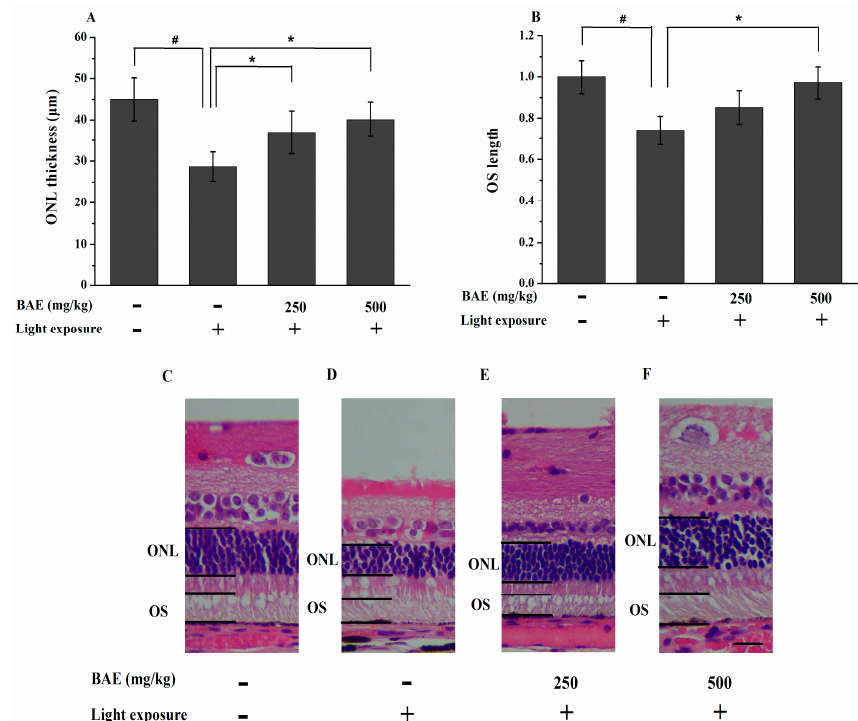
Figure 3. Effect of bilberry anthocyanin extract on the thickness of the outer nuclear layer ( A ) and the outer segment length ( B ) for the rabbit retina at 7 days after light exposure (18,000 lx) were examined by histological analysis. Thickness of the ONL were measured within 250–2750 μ m (counted at every other 500 μ m interval) of the superior and inferior edges to the optic nerve head (ONH) based on photographs of HE-stained sections. The OS length was measured 1 mm from the ONH in the superior and inferior retina. Data are expressed as the mean ± standard deviation ( n = 8). #, * p < 0.05 ( t -test); ( C – F ) Representative images of the HE-stained sections of retinas of the rabbits. ONL: outer nuclear layer; OS: outer segment. Scale bar: 20 μ